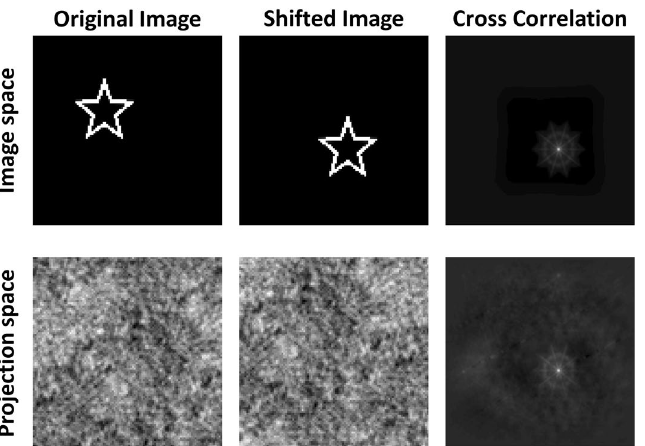
Figure 1. For a cyclic sampling matrix, spatial translation of the image results in the same translation in projection space. The top row shows an image of a star, a shifted version of that image, and the corresponding cross-correlation between the two images. On the bottom row, the first two panels show the corresponding projection images, calculated by applying Eq. 1 on the respective images on the top row. While the spatial translation is difficult to observe visually in the projection images, it is readily detected in the cross correlation between the two images, shown in the third panel in the second